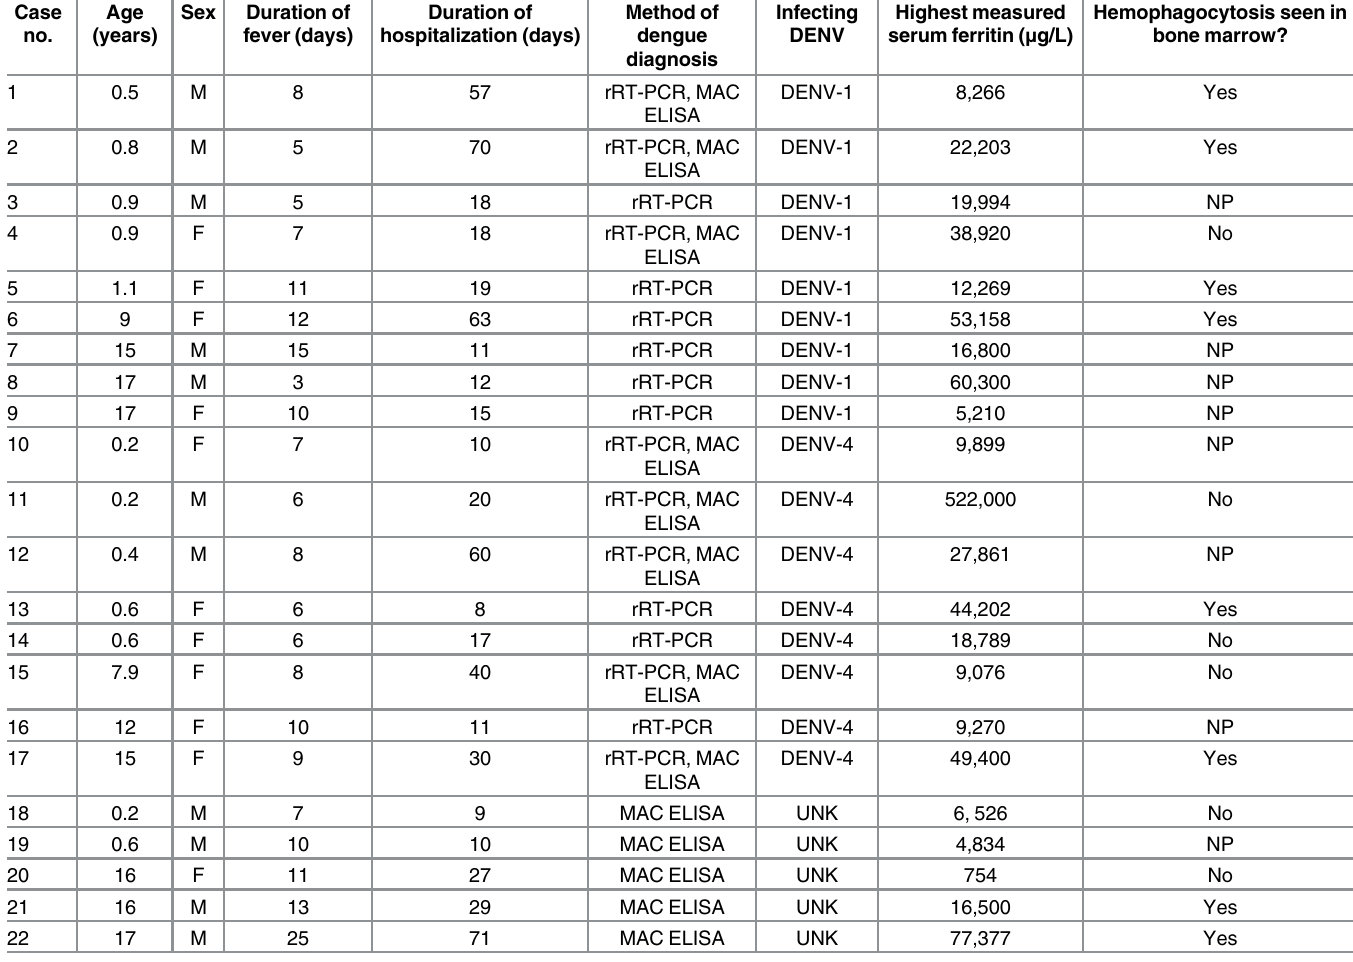
Abbreviations: DENV = dengue virus; F = female; M = male; rRT-PCR = real-time reverse transcriptase-polymerase chain reaction; MAC ELISA = IgM antibody capture enzyme linked immunosorbent assay; UNK = unknown; NP = not performed